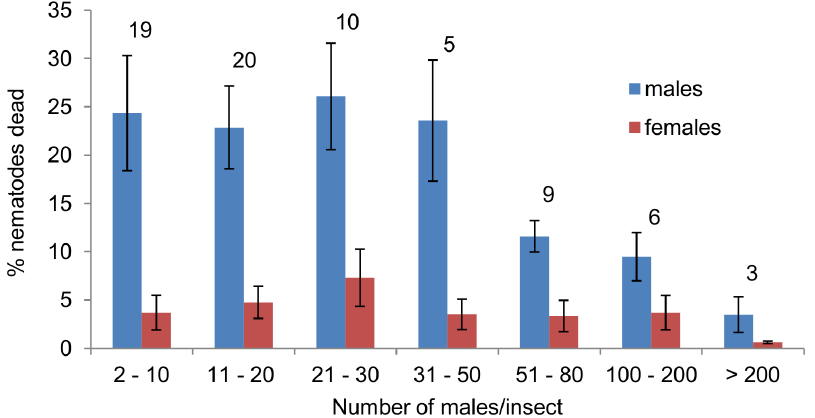
Figure 1. Effect of competitor density on killing in vivo. Percentage mortality (mean 6 S.E.) of first generation adult males and females of the nematode Steinernema longicaudum in cadavers of the wax moth Galleria mellonella , with varying density, classed by number of males found in each cadaver. The number above the bar is the number of cadavers in each class.